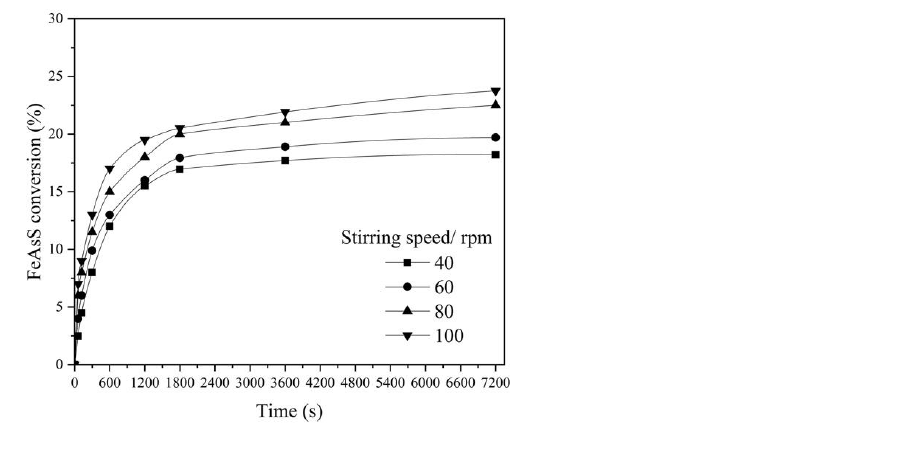
Figure 3. Effect of stirring speed on hydrothermal conversion of FeAsS (503 K; 0.1 mol/L of H 2 SO 4 ; 0.16 mol/L of Cu; 10–29 µ m).